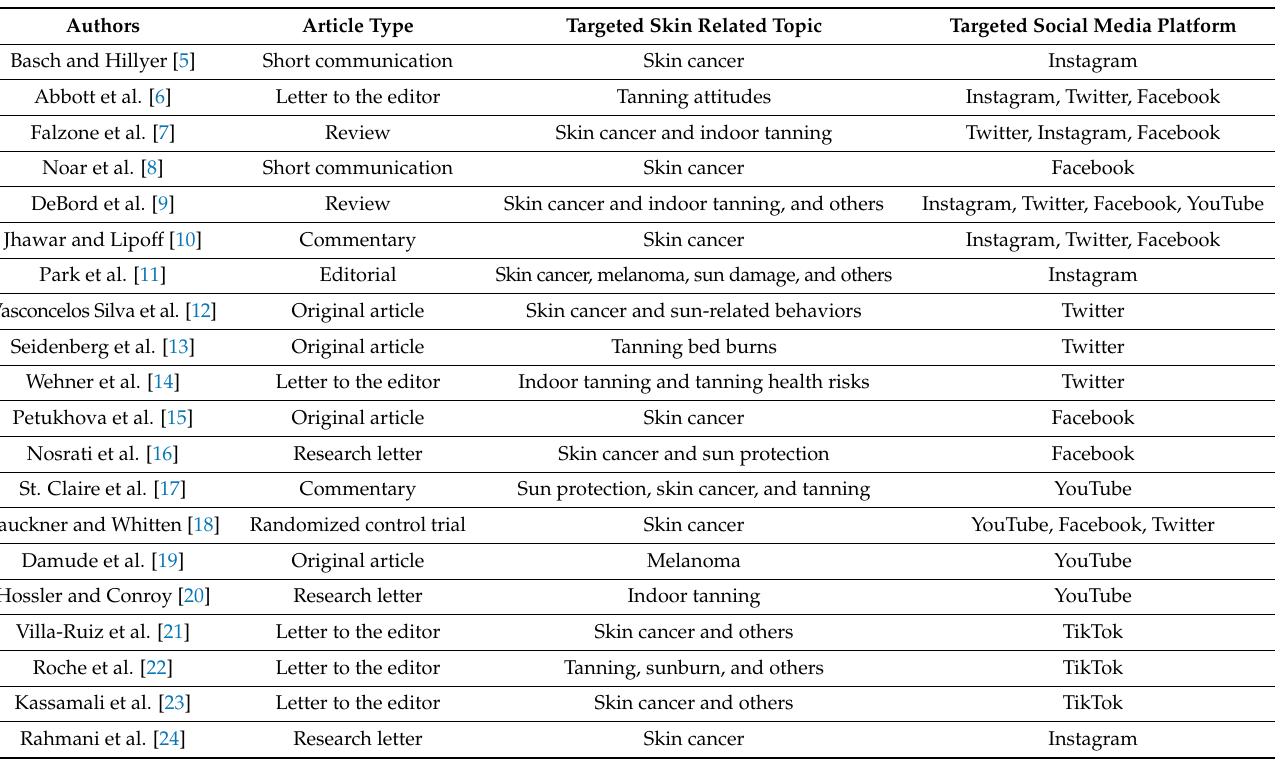
Table 1. Article characteristics in terms of type of article, targeted issue, and social media discussed.